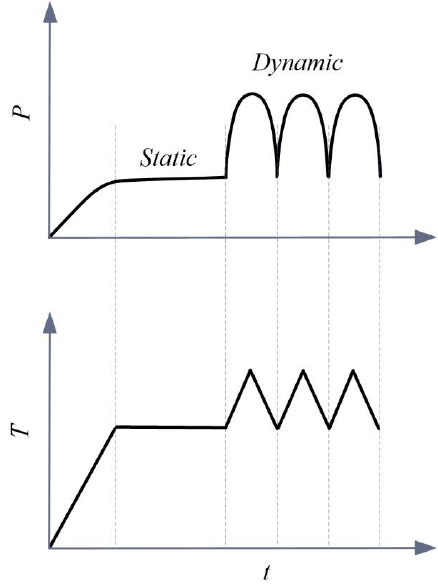
Figure 7. Exploiting controlled static and dynamic compression benefits from a memory bandage using a programmed heating stimulus.